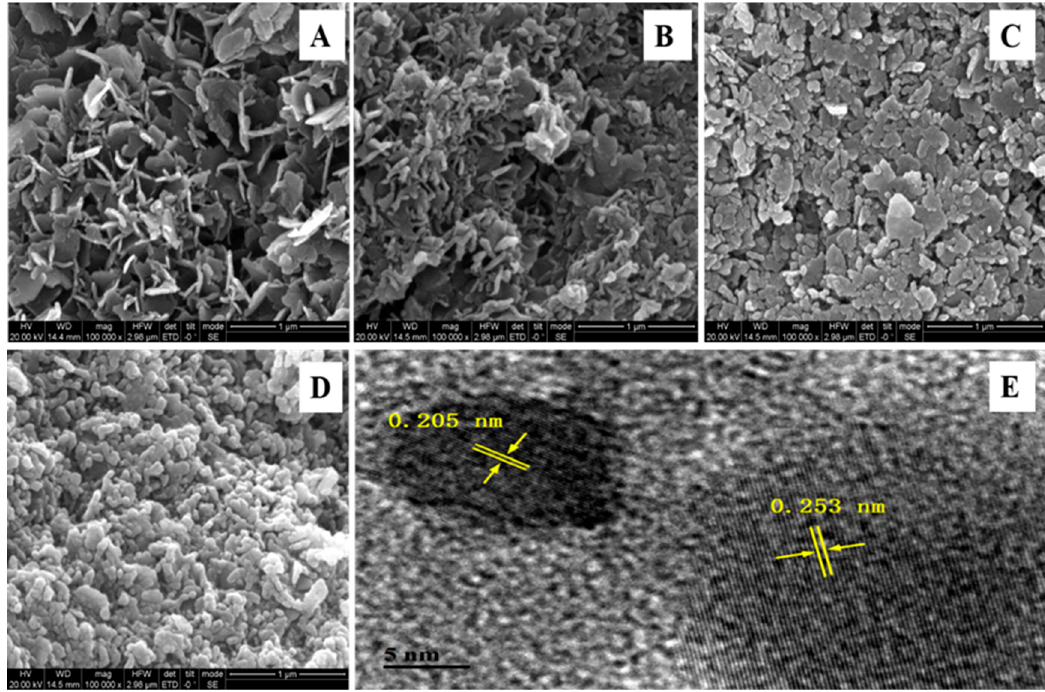
Figure 2 . SEM images of the ( A ) CuMgFe-3LDH, ( B ) CuMgFe-4LDH, ( C ) CuMgFe-3LDO, and ( D ) CuMgFe-4LDO. HRTEM image of ( E ) CuMgFe-4LDO.